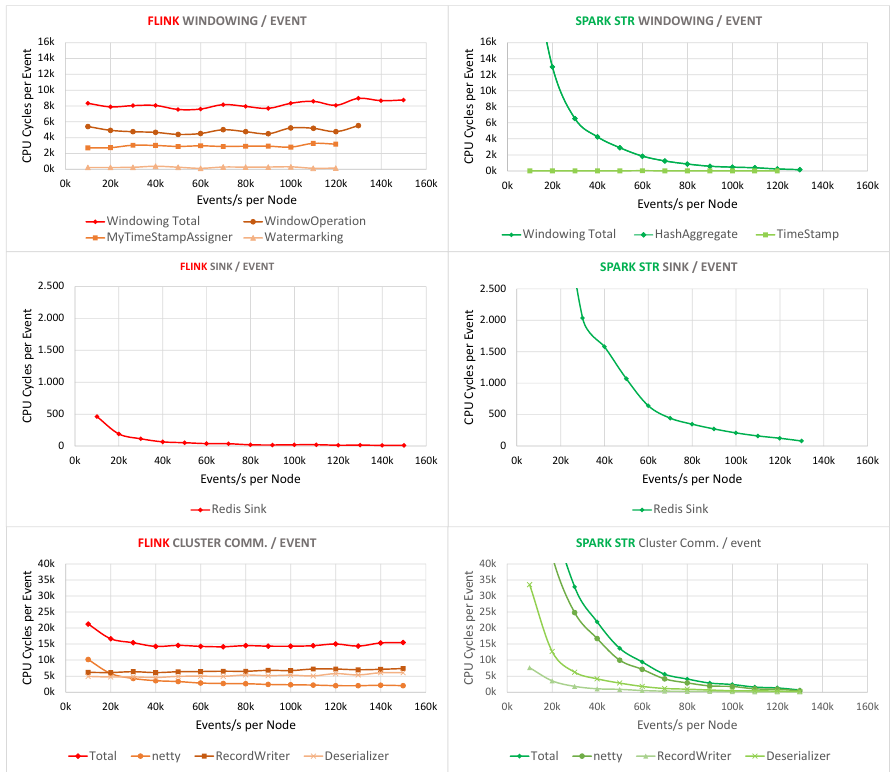
Figure 9. Drilldown: window, sink, and cluster